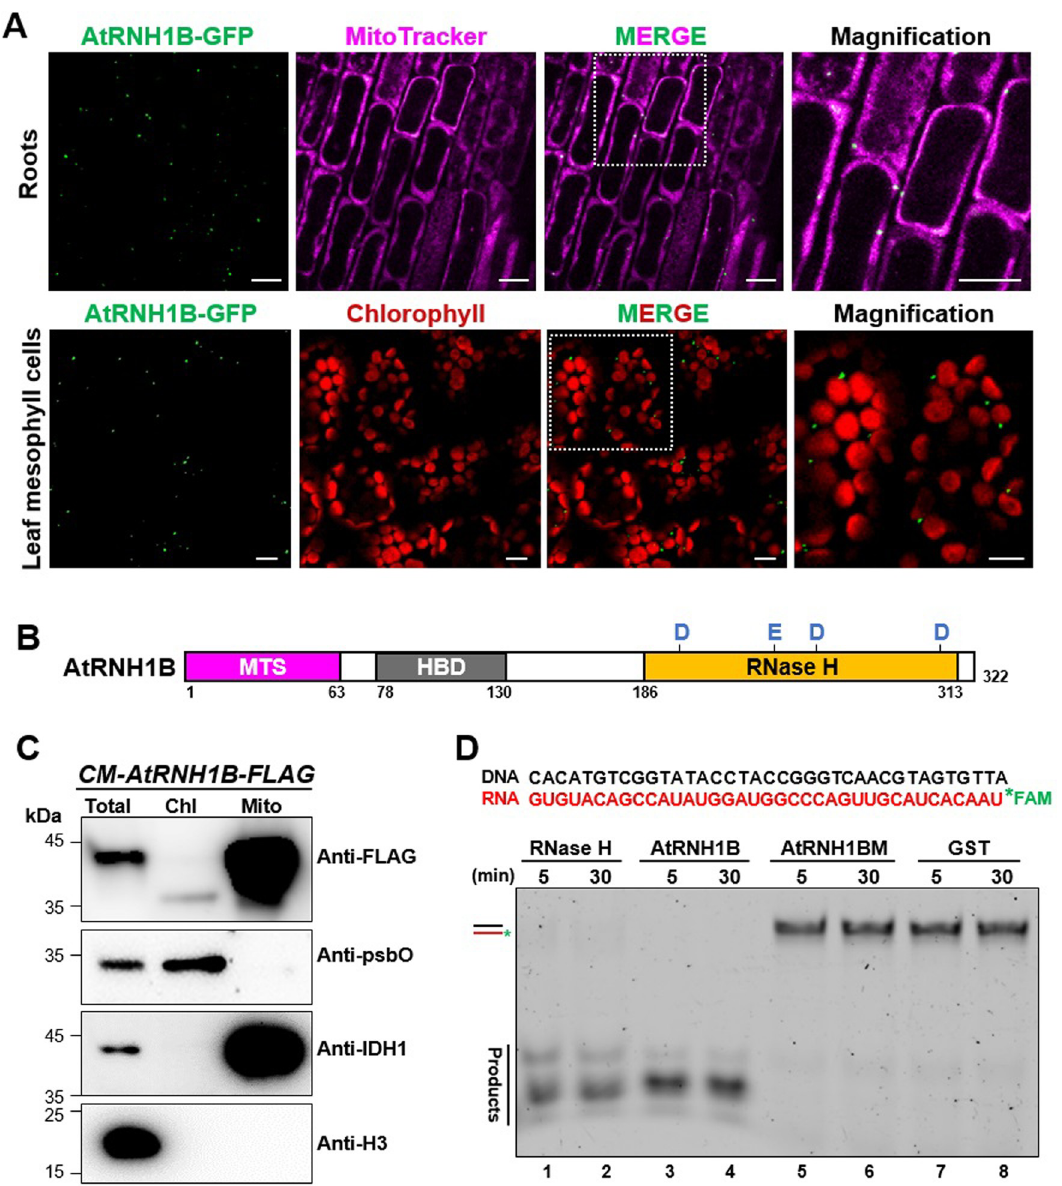
Fig 1. Arabidopsis AtRNH1B is a mitochondrial RNase H1 protein. (A) Confocal microscopy of roots (upper) and leaves (bottom) of AtRNH1Bpro : AtRNH1B - GFP atrnh1b transgenic plants. Green = GFP, magenta = MitoTracker, and red = chlorophyll. White boxes indicate the regions magnified on the right. Scale bars, 10 μ m. (B) AtRNH1B protein structure. HBD, hybrid binding domain; MTS, mitochondrial targeting signal; RNase H, catalytic domain (containing 4 conserved active sites: D191, E231, D255, and D305). D, Asp; E, Glu. (C) Characterize the localization of AtRNH1B protein by immunoblot. Intact chloroplasts and mitochondria were isolated from 3-week-old CM-AtRNH1B-FLAG transgenic plants. Anti-FLAG monoclonal antibody was used to detect the AtRNH1B-FLAG, and polyclonal antibodies anti-psbO, anti-IDH1, and anti-H3 were used to indicate chloroplast, mitochondria, and total protein fractions, respectively. Chl, proteins from isolated chloroplasts; Mito, proteins from isolated mitochondria; Total, total proteins from leaves. (D) RNase H activity of AtRNH1B and AtRNH1BM. The RNA:DNA hybrid substrate with FAM-labeled RNA (100 nM) was incubated with commercial RNase H and 0.55 μ g purified GST-AtRNH1B, 0.55 μ g GST-AtRNH1BM, and 2.8 μ g GST protein for 5 minutes and 30 minutes. The data underlying this figure can be found in S1 Raw Images. GFP, green fluorescent protein; GST, glutathione-S-transferase; H3, histone 3; IDH1, isocitrate dehydrogenase 1; psbO, photosystem II subunit O.